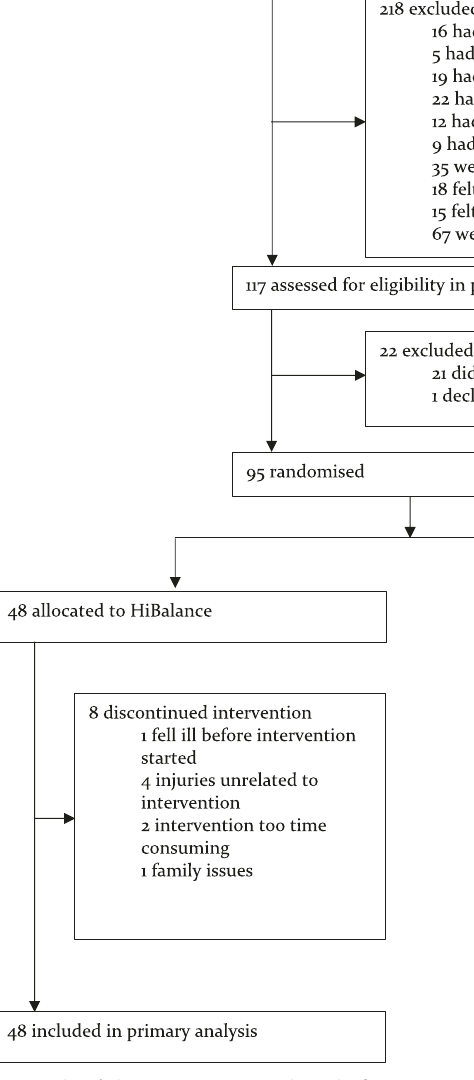
Fig. 1 Trial fl owchart. Details of the recruitment and study fl